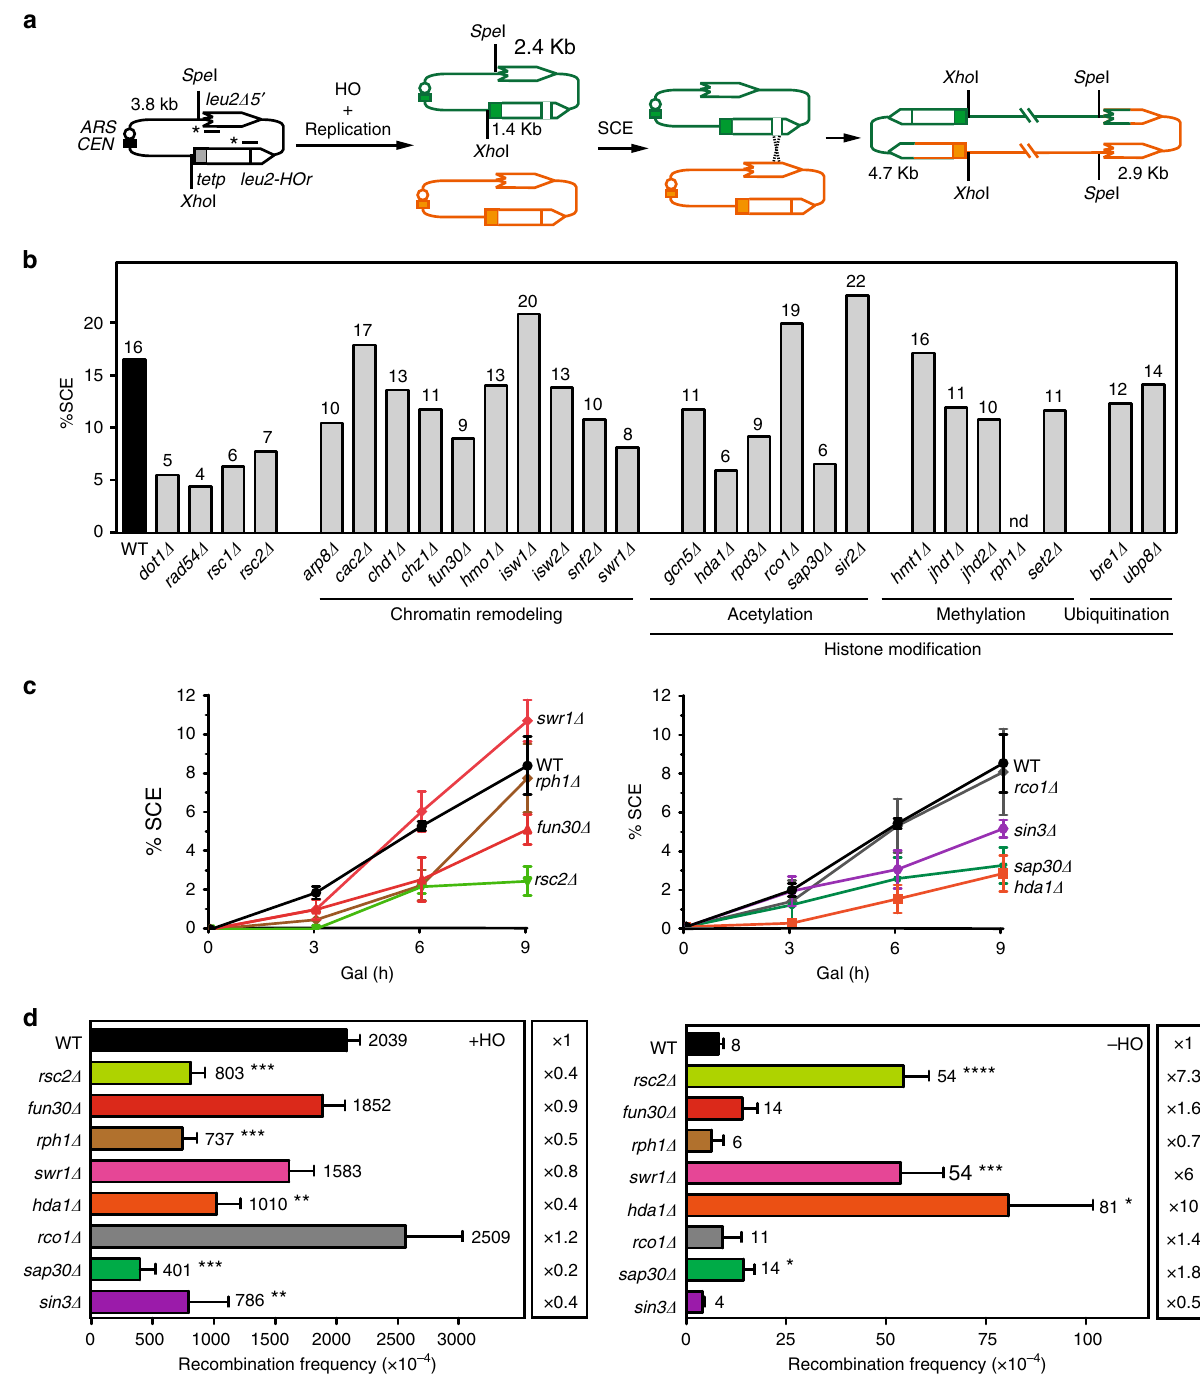
Fig. 1 Screening for chromatin factors involved in SCR. a Schemes of the TINV-HO system and SCE intermediates produced after HO-induced replication- born DSBs. Fragments generated after Xho I – Spe I digestion are indicated with their corresponding sizes in kb and were detected by Southern blot hybridization with a LEU2 probe (line with an asterisk). b Quanti fi cation of the SCE 4.7-kb fragment detected after 9 h of HO induction in wild type (BY4741) and the indicated mutant strains from the Euroscarf collection (see Supplementary Table 1) transformed with the pTHGH plasmid that contains both the TINV-HO system and GAL::HO ( n = 1). c Quanti fi cation of the 4.7-kb SCE fragments during a time-course experiment after HO induction performed in wild type (WSR-7D), rsc2 Δ (WSRSC2), fun30 Δ (WSFUN30), rph1 Δ (WSRPH1), swr1 Δ (WSSWR1), hda1 Δ (WSHDA1), rco1 Δ (WSRCO1), sap30 Δ (WSSAP30), and sin3 Δ (WSSIN3) transformed with pRS316-TINV ( n ≥ 2). d Analysis of spontaneous ( − HO) and HO-induced ( + HO) recombination frequencies in wild type (WSR-7D), rsc2 Δ (WSRSC2), fun30 Δ (WSFUN30), rph1 Δ (WSRPH1), swr1 Δ (WSSWR1), hda1 Δ (WSHDA1), rco1 Δ (WSRCO1), sap30 Δ (WSSAP30), and sin3 Δ (WSSIN3) strains transformed with pRS316-TINV ( n ≥ 3). Means and SEM are plotted in c and d . * p ≤ 0.05; ** p ≤ 0.01; *** p ≤ 0.001; **** p ≤ 0.0001 (two-tailed Student ’ s t- test). See also Supplementary Fig. 1. nd, not determined. Data underlying this fi gure